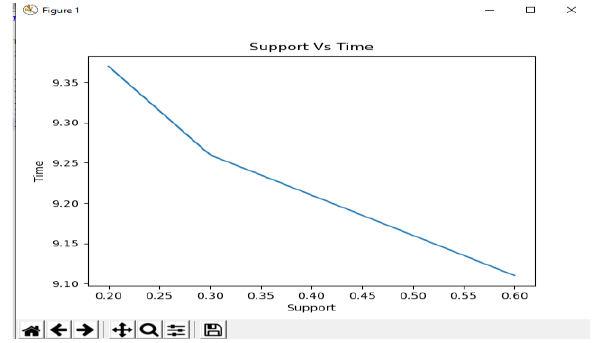
Fig 11:- FP-Growth Of Movie Rating